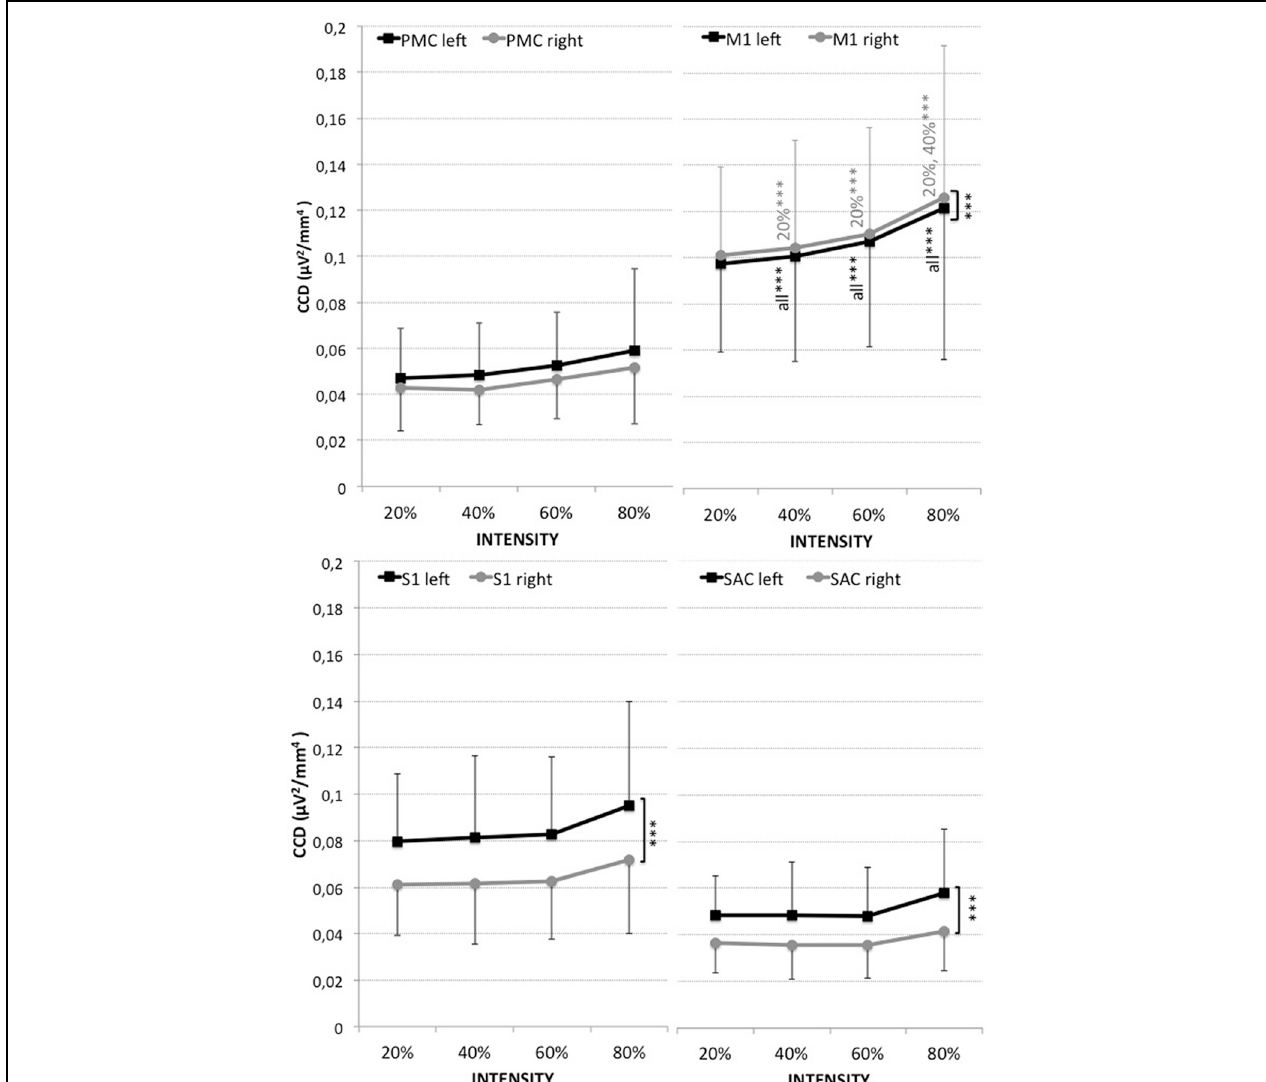
FIGURE 1 | Cortical current density (CCD, µ V 2 /mm 4 ) of the four regions of interest (PMC, M1, S1, SAC) within the left (black) and right (gray) hemisphere for measurements at 20, 40, 60, and 80% of the maximal